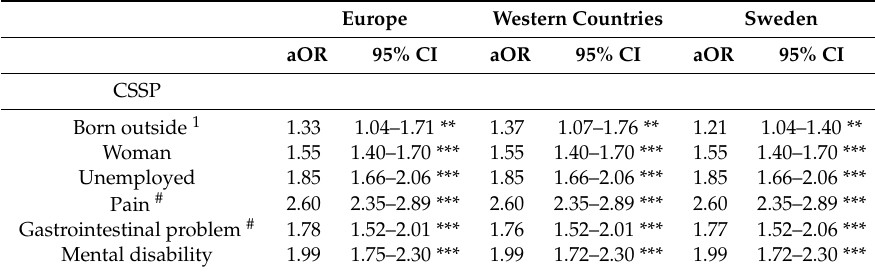
Table 3. Adjusted odds ratios (aOR) with 95% confidence intervals for di ff erent countries of birth as having CSSP.